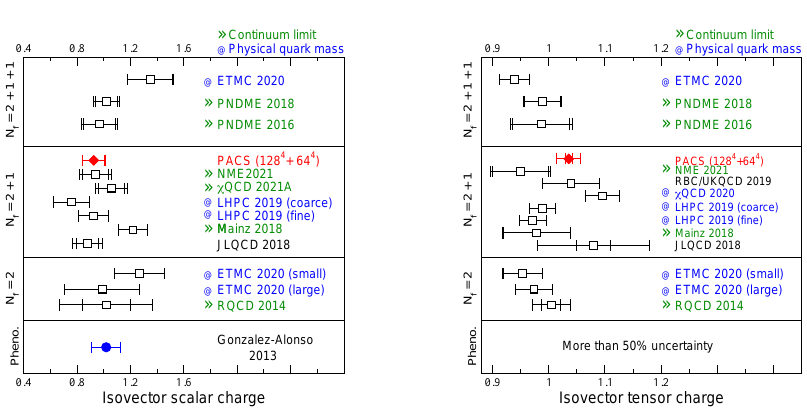
Figure 3: Comparison of our results (red diamonds) with the other lattice results (black squares) [21] and the phenomenological value (blue circle) [23] for g S (left panel) and g T (right panel). The inner error bars represent the statistical uncertainties, while the outer ones represent the total uncertainties given by adding the statistical and systematic errors in quadrature. Blue labels indicate that the analysis includes the data from lattice QCD simula- tions near the physical point, while green labels indicate that the continuum extrapolation is achieved. These figures are reprinted from Ref.